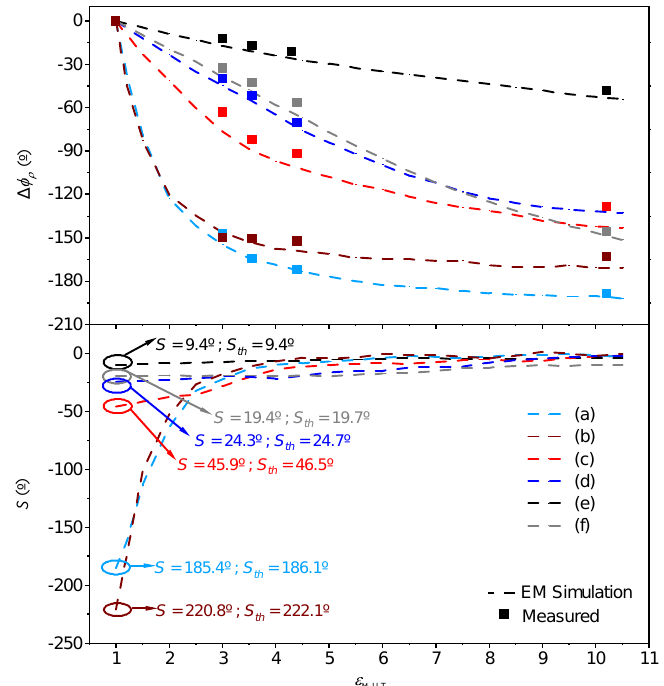
Figure 31. Measured and simulated phase of the reflection coefficient for the sensors of Figure 30, and simulated sensitivity: ( a ) sensor with step-impedance discontinuity and Z 1 < Z 0 < Z s ; ( b ) sensor with step-impedance discontinuity and Z 1 > Z 0 > Z s ; ( c ) sensor with uniform mismatched sensing line and Z s > Z 0 ; ( d ) sensor with uniform mismatched sensing line and Z s < Z 0 ; ( e ) sensor based on a 90 ◦ uniform 50- Ω sensing line; and ( f ), sensor based on a 180 ◦ uniform 50- Ω sensing line. The measured dielectric loads are 3 mm slabs of uncoated PLA ( ε MUT = 3), Rogers RO4003C ( ε MUT = 3.55), FR4 ( ε MUT = 4.4) and Rogers RO3010 ( ε MUT = 0.2) substrates. The sensitivities in the limit of small perturbations are given in absolute values. Reprinted with permission from Ref.